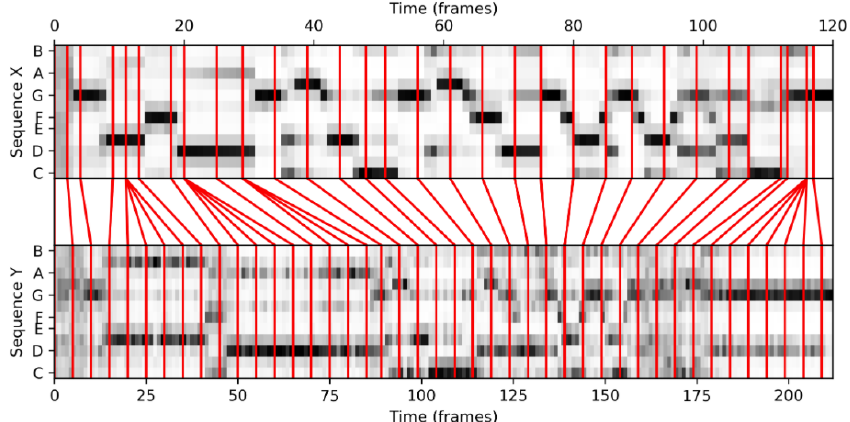
Figure 10. Tuning procedure using a comb-filter approach. Left : Similarity function with maximizing tuning parameter at 13 cents. Right : Frequency distribution (with logarithmic frequency axis) and maximizing comb template (shown as red vertical lines).